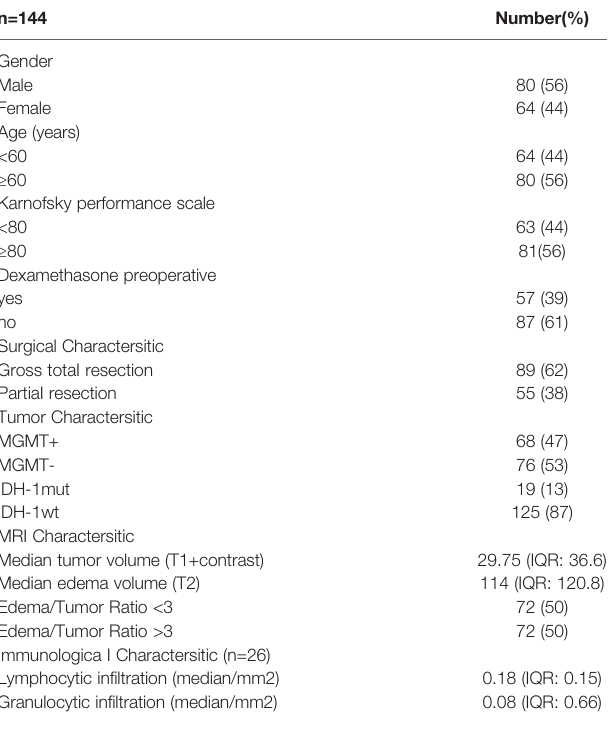
FIGURE 2 | Representative immunohistochemistry slides with anti-CD3 (lymphocytic) and anti-CD15 (myelocytic) tumor in fi ltration in GBM patients allocated according to high vs low edema to tumor TABLE 1 | Patient characteristics.